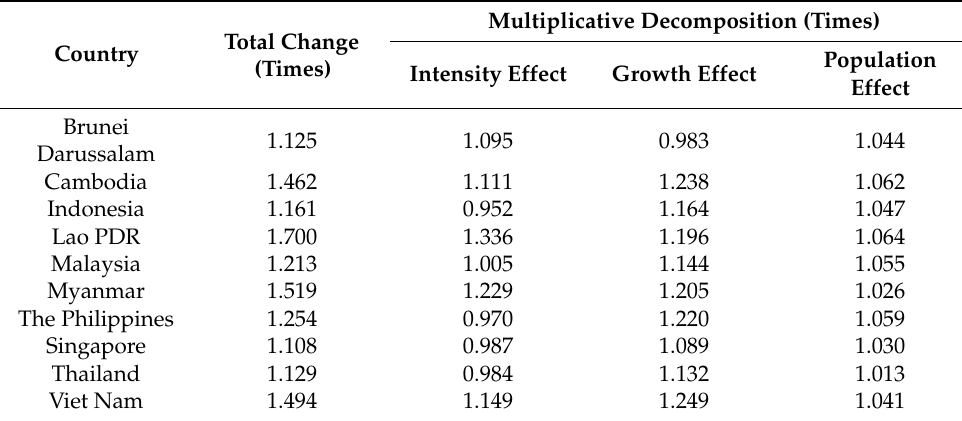
Table 3. LMDI decomposition result: Multiplicative decomposition from 2015 to